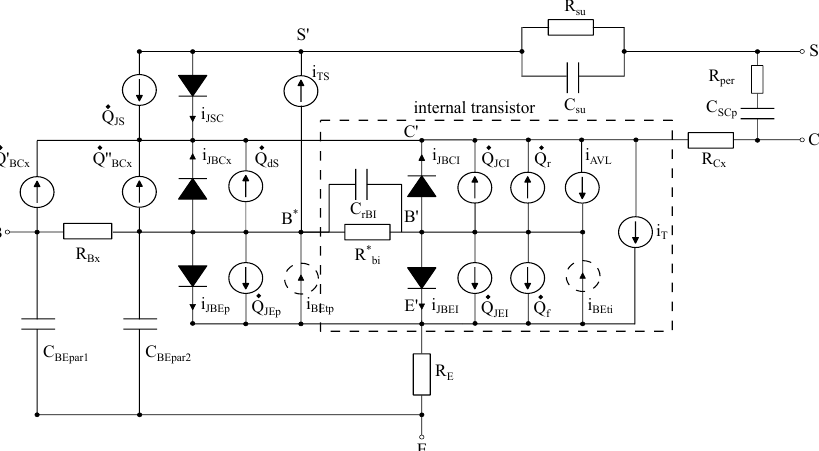
Figure 4. Large-signal equivalent circuit of HICUM with an improved substrate network [18].